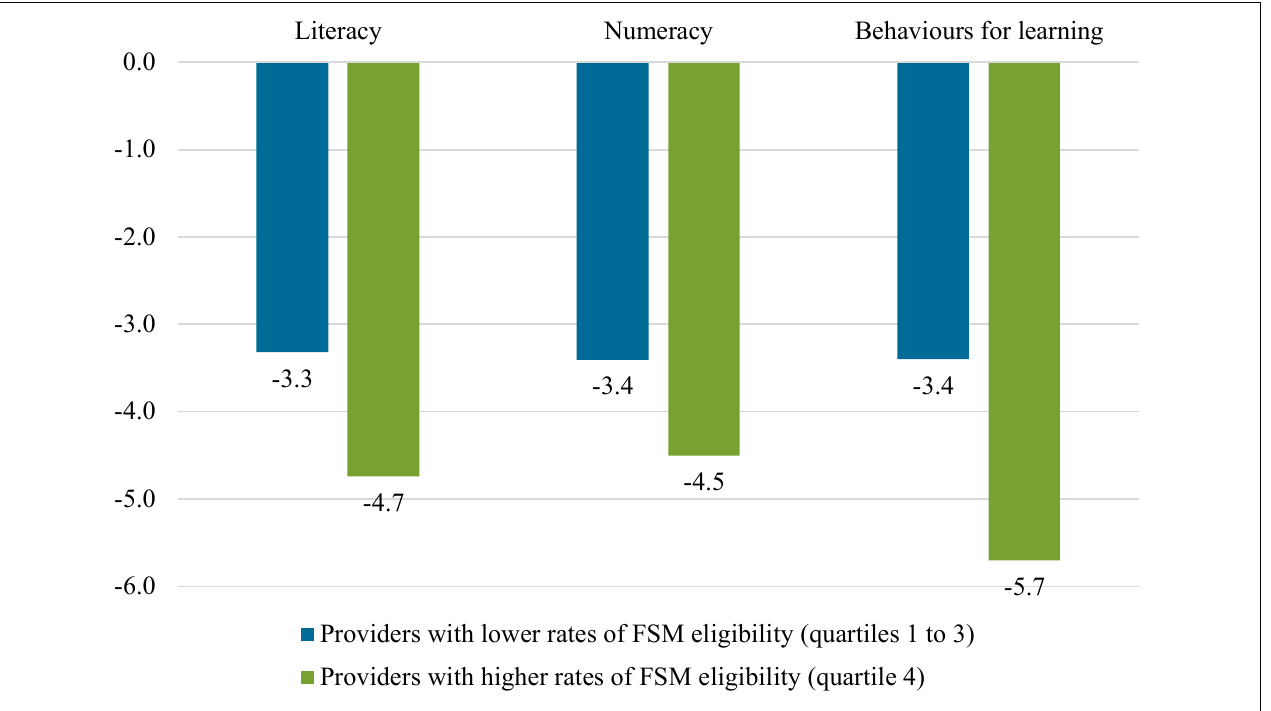
FIGURE 1 | Mean reported learning losses for pupils in specialist provision (in months) by FSM eligibility. Base: 189 respondents (1 respondent missing due to lack of FSM eligibility data) . 56 respondents were in the top quartile for FSM eligibility . Results for literacy and behaviours for learning significant ANOVA at p < 0.05. Result for numeracy significant ANOVA at p <